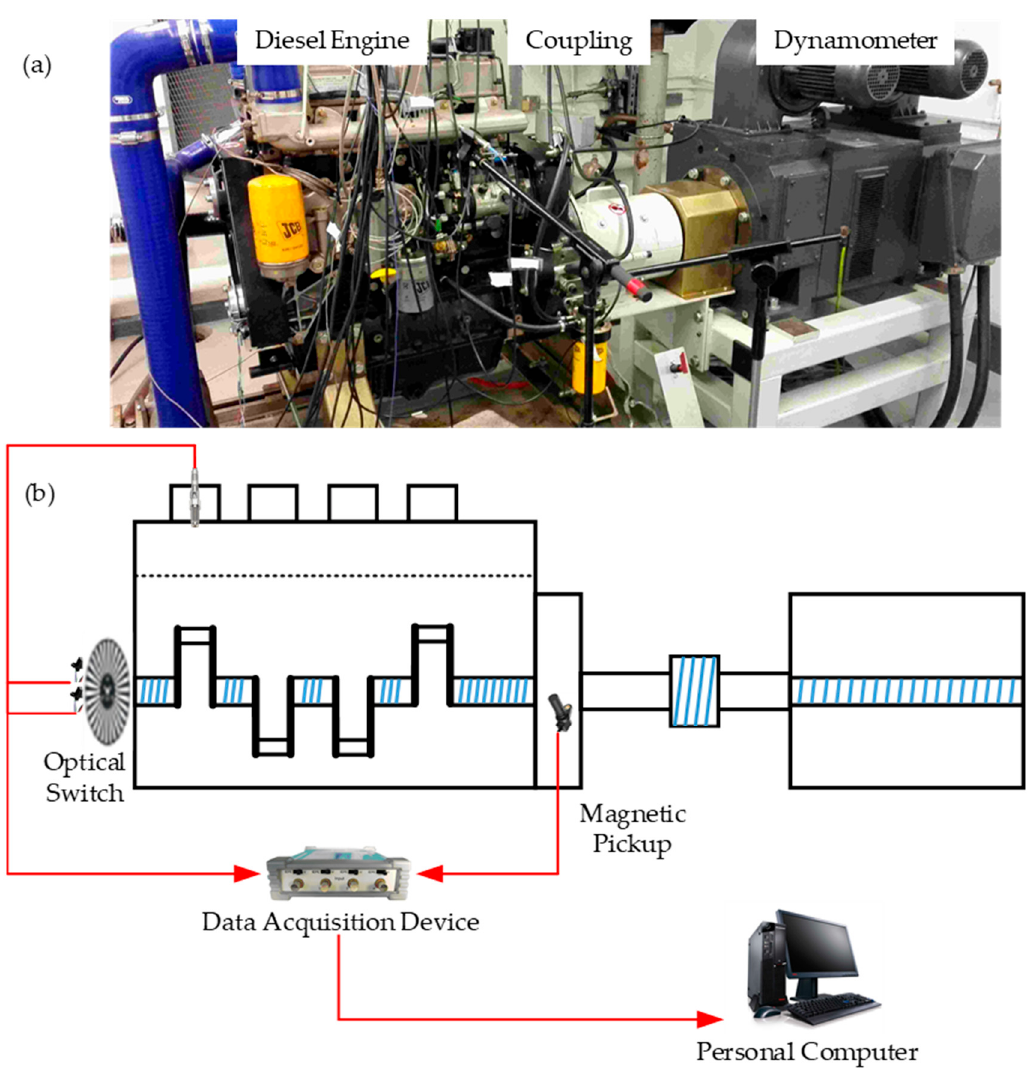
Figure 1. Layout of the engine test rig: ( a ) photograph of the test rig; ( b ) schematic diagram.